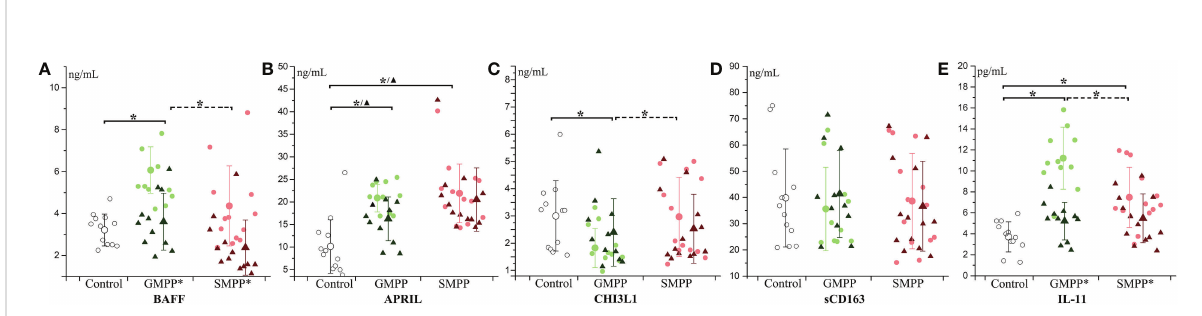
FIGURE 3 The level of B cell and macrophage related cytokines: (A) BAFF; (B) APRIL; (C) CHI3L1; (D) sCD163; (E) IL-11. Indications of groups and symbols are the same as described in Figure 2.